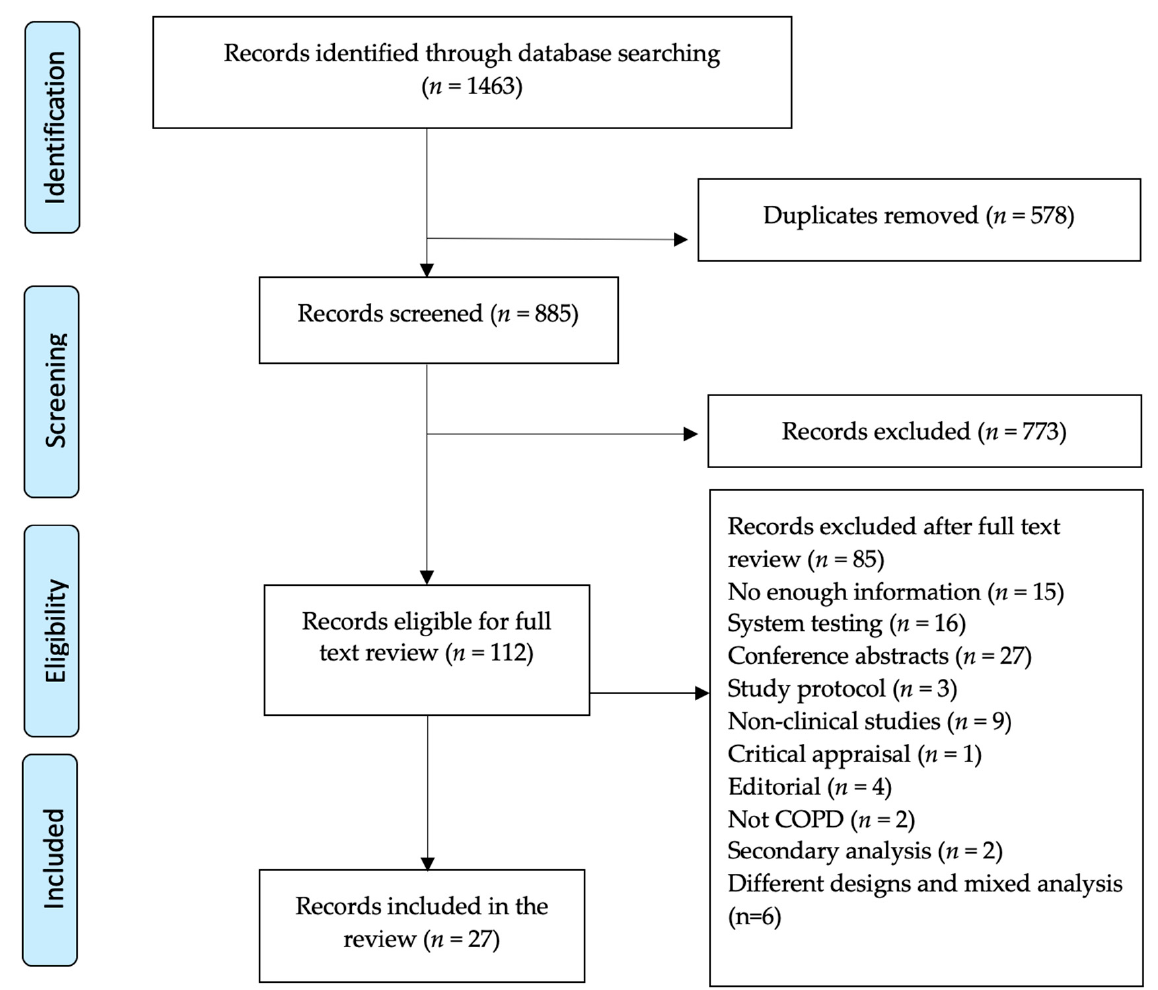
Figure 1. PRISMA flow diagram showing studies related to the TH (telehealth) interventions in COPD (with Chronic Obstructive Pulmonary Disease ).